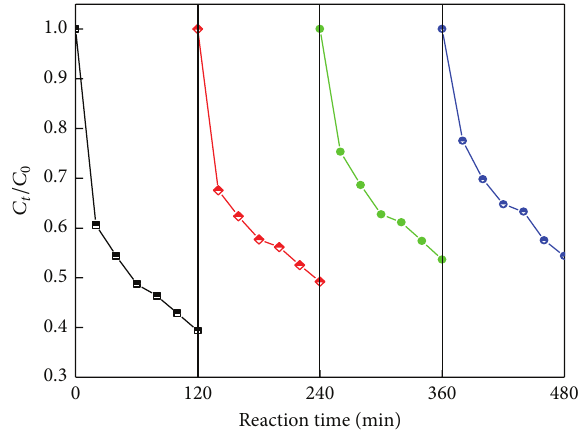
Figure 8: Recycling runs in the photocatalytic degradation of reactive brilliant blue